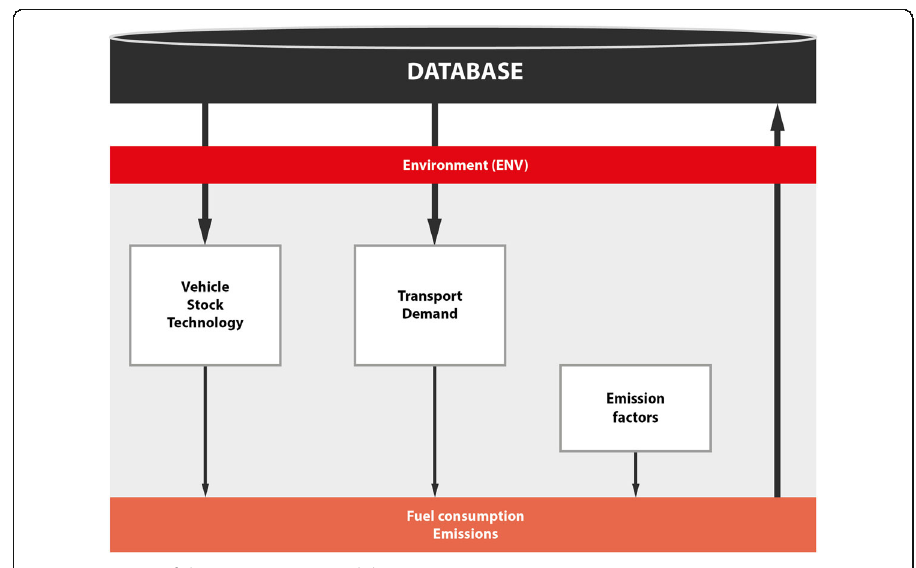
Fig. 7 Structure of the Environment